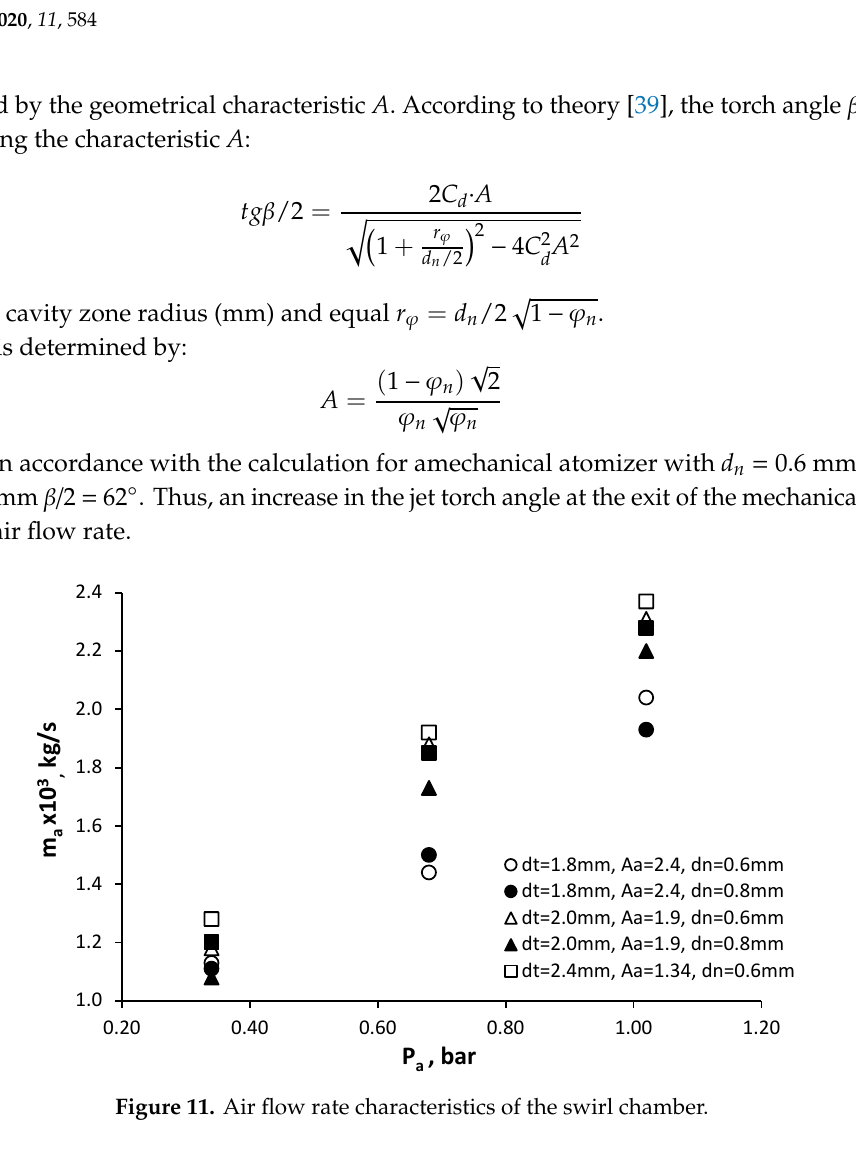
Figure 13. The influence of operation conditions on the atomization quality of the atomizer assembly. ( а ) d t = 2.0 mm, d n = 0.6 mm, ALR = 0.69, P w = 2.5 bar, Р а = 0.35 bar; ( b ) d t = 2.0 mm, d n = 0.6 mm, ALR = 1.19, P w = 3 bar, P a = 1 bar; ( c ) d t = 2.4 mm, d n = 0.8 mm, ALR = 0.67, P w = 2.5 bar, Р а = 0.35 bar; ( d ) d t = 2.4 mm, d n = 0.8 mm, ALR = 0.97, P w = 2.9 bar, P a = 1 bar. As can be seen from Figure 13, the introduction of a swirling air flow at the exit of the jet from the mechanical atomizer significantly reduces the diameter of the droplets, even at low supply